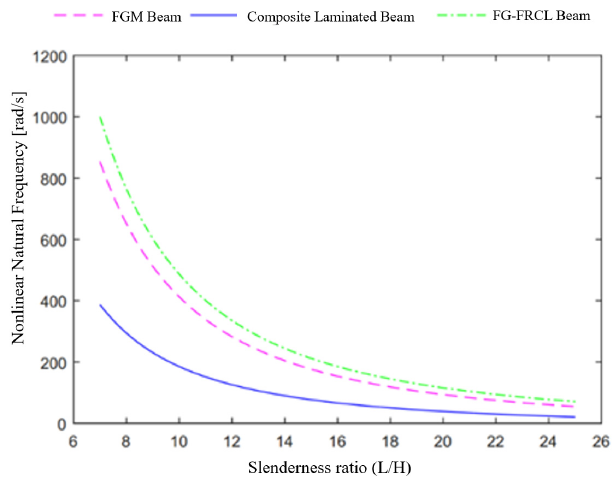
Figure 2. Variation of nonlinear natural frequency versus slenderness ratio.